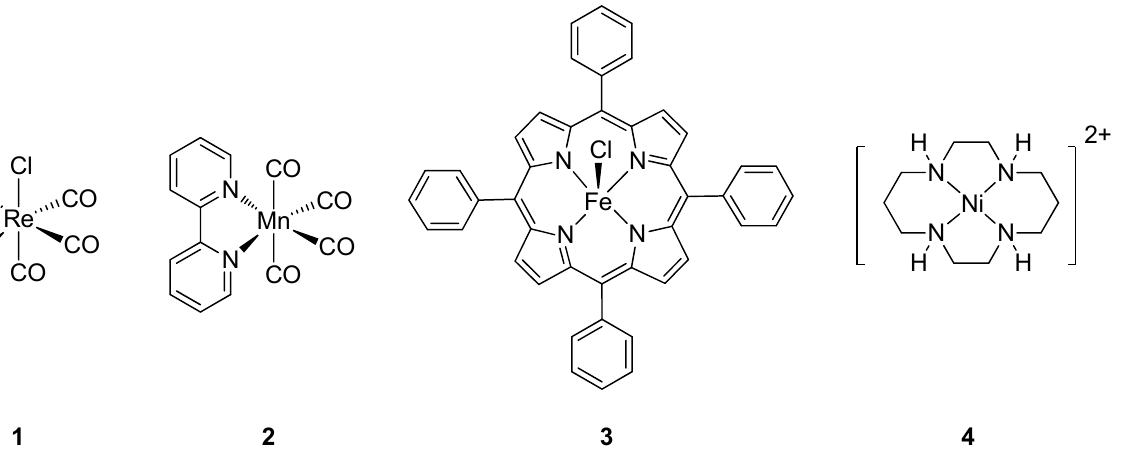
Figure 1. Some of the most ‐ known molecular catalysts for CO 2 reduction.